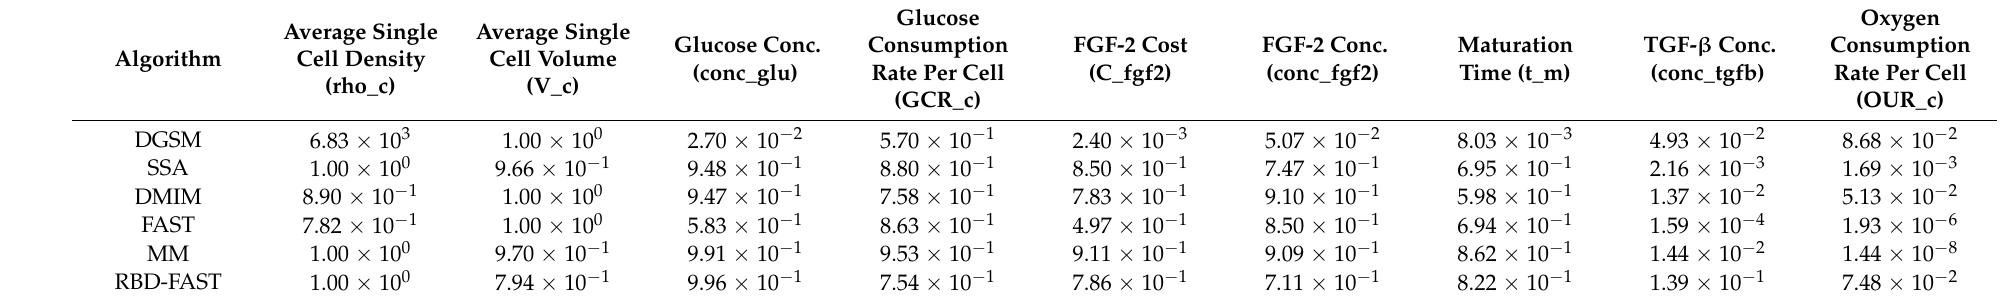
Table A8. Sensitivity analysis numerical